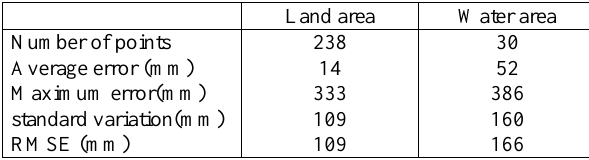
Table 1. Comparison of Cross-section Survey and Point